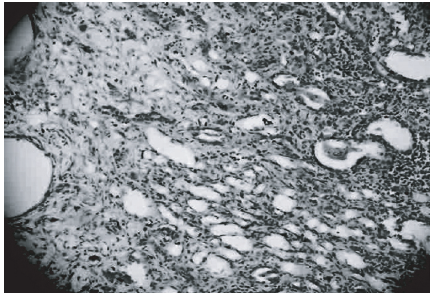
Figure 3. Mononuclear cell infiltration and interstitial fibrosis between the dilated tubules in kidney of rat chronically treated with CDDP. HE